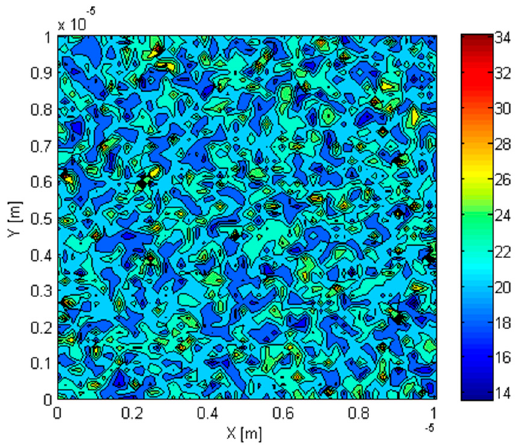
Figure 7. Distribution of the effective thermal conductivity in the RVE.